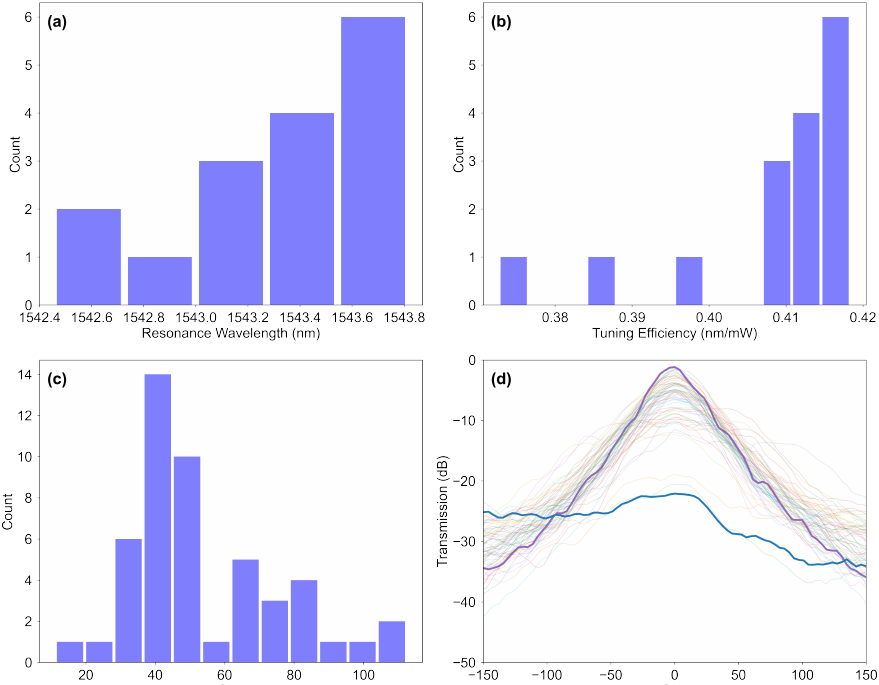
Figure 3. ( a ) Histogram of resonant wavelength, mean = 1543.4 and standard deviation = 0.39 nm. ( b ) Tuning efficiency mean = 0.41 nm/mW and standard deviation = 0.012 nm/mW. ( c ) Bandwidth histogram with median = 48.7 GHz. ( d ) Transfer spectra of all ring resonator filters.